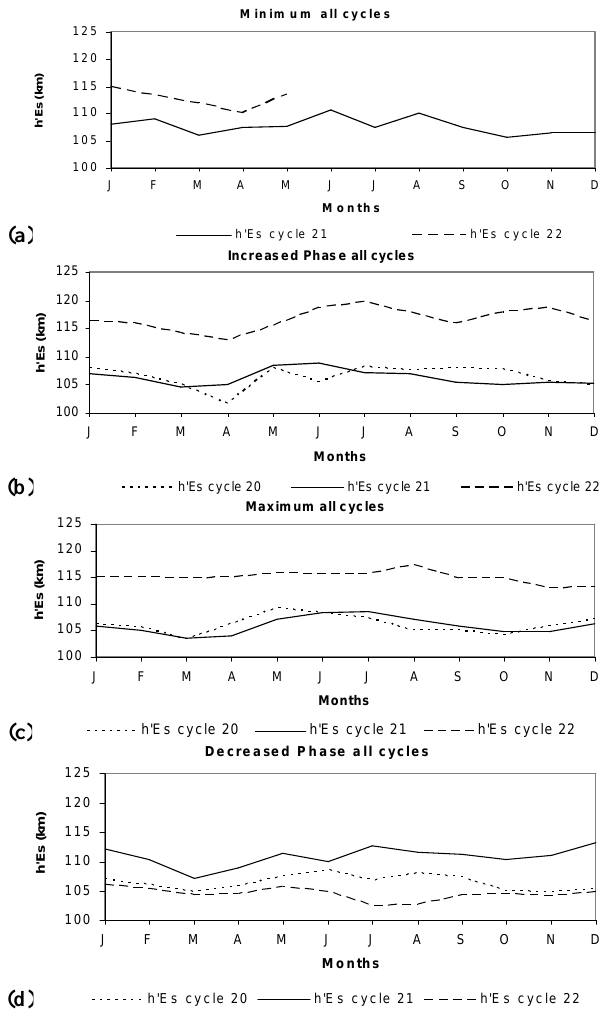
ing: quiet days activity acts at minimum phase, fluctuating activity arises during increasing phase, shock event activity occurs during solar maximum and recurrent activity acts at declining phase. Thus, except maximum phase where SSC storms produce shock event activit, storms are generated by solar wind related to fluctuating activity and recurrent activ- ity. The different solar events signatures appear in seasonal and diurnal profiles of ionospheric parameters. This will be underlined during the following discussion. fo F2 monthly evolution shows seminanual anomaly,